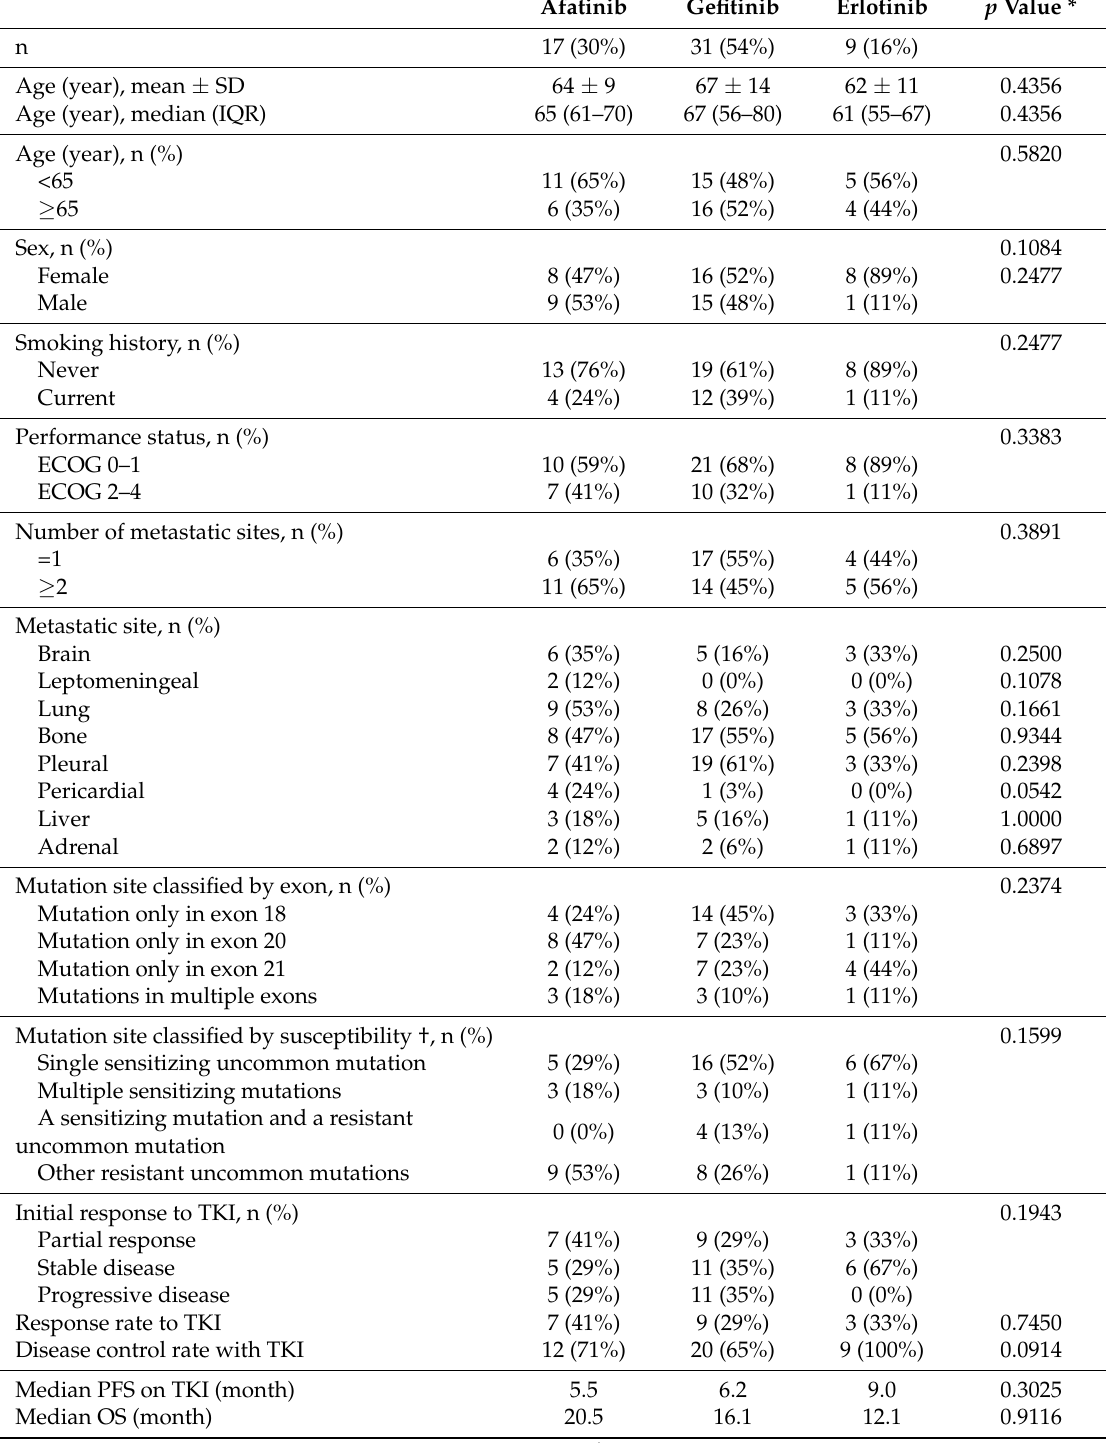
Table 4. Characteristics of the patients with stage IV lung cancer harboring uncommon mutation receiving a first-line tyrosine kinase inhibitor (TKI), classified by the drug